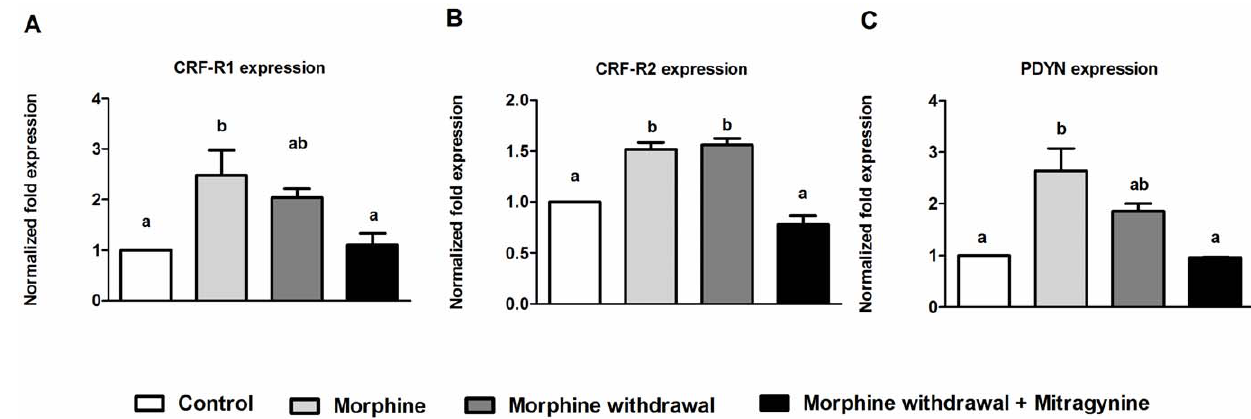
Figure 4. Effect of two weeks chronic morphine treatment (1.5 mg/L), 24-h morphine withdrawal and morphine withdrawal in presence of 2 mg/L mitragynine on the mRNA expression of CRF-R1, CRF-R2 and PDYN in zebrafish. Data are presented as mean 6 SEM of three independent experiments. Mean values were subjected to one way ANOVA and where applicable, ranked by Tukey test (P , 0.05); mean percentage values with same letter are not significantly different.